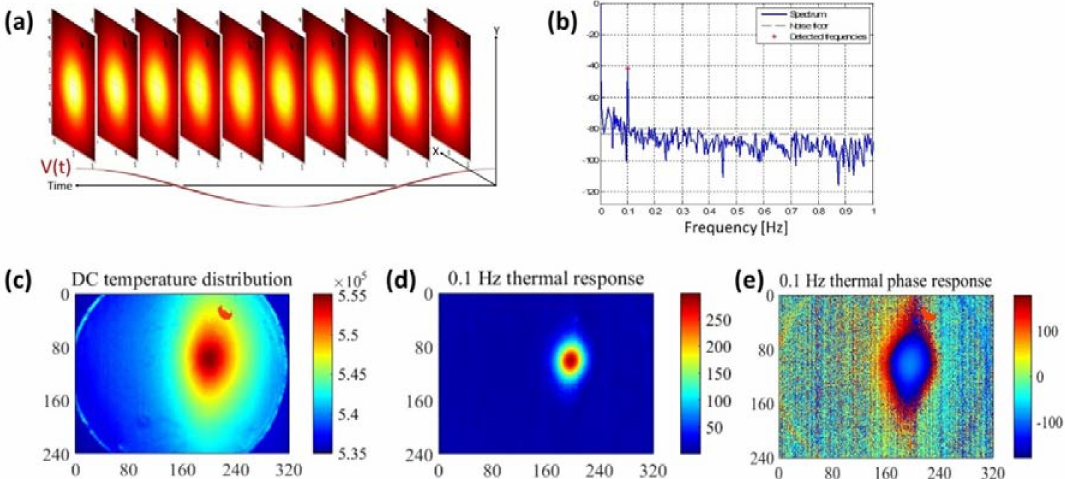
Figure 4. ( a ) A time sequence of thermal images in response to a 0.05Hz sinusoidal voltage; ( b ) The spectrum of a pixel in the image showing the spectral components in DC and 0.1 Hz; ( c ) Magnitude image of the DC component showing the broad response; ( d ) Magnitude image of the 0.1 Hz AC component showing a much narrower response; ( e ) Phase image of the 0.1 Hz AC component that allows easy separation of the signal from the sounding